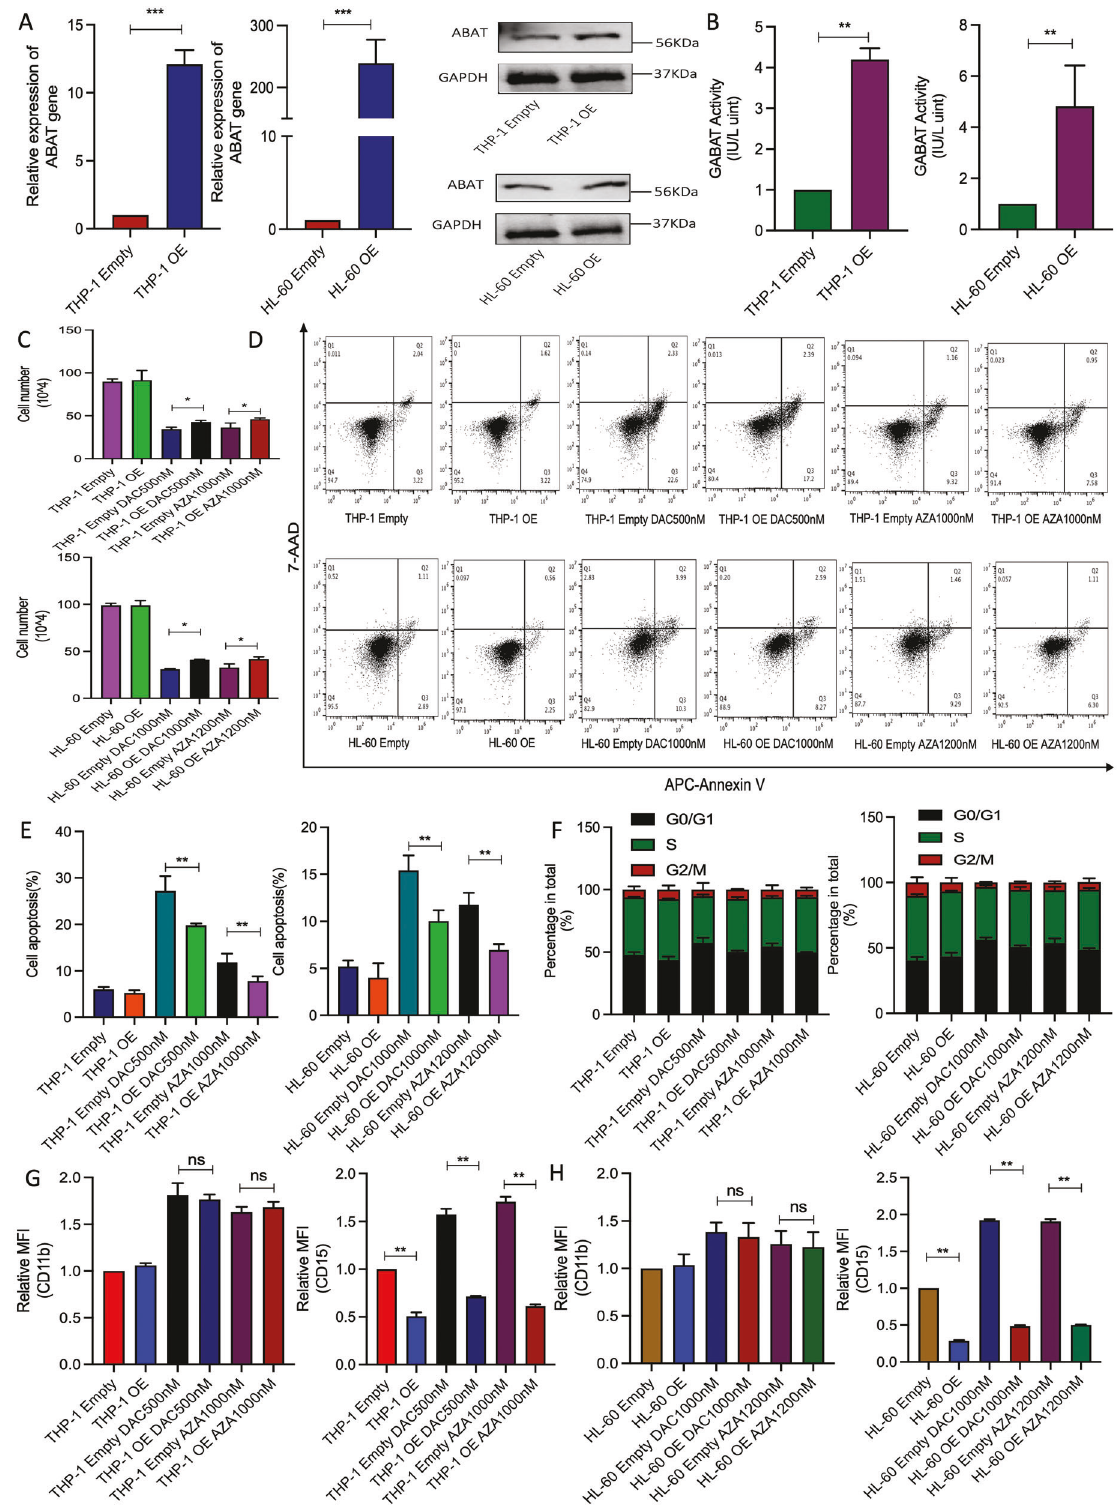
Fig. 2 Functional analysis of THP-1 and HL-60 cells with ABAT gene overexpression and HMAs treatment. A mRNA and protein expression of ABAT gene in THP-1 and HL-60 cells with ABAT overexpression. B GABAT enzyme activity in both cell lines with ABAT overexpression. C Total cell number after ABAT overexpression and HMAs treatment. Representative fi gures ( D ) and percentage ( E ) of apoptosis in ABAT overexpressed cells treated with HMAs. F Cell cycle analysis after ABAT overexpression and HMAs treatment. Relative expression of CD11b and CD15 in ABAT overexpressed THP-1 ( G ) and HL-60 ( H ) cells treated with HMAs. Data were shown as mean ± SEM from three biological samples. * P < 0.05, ** P < 0.01, *** P < 0.001. Student ’ s t -test (two groups) or one-way ANOVA analysis followed by Dunnett ’ s test (multiple groups). ns. not signi fi cant.